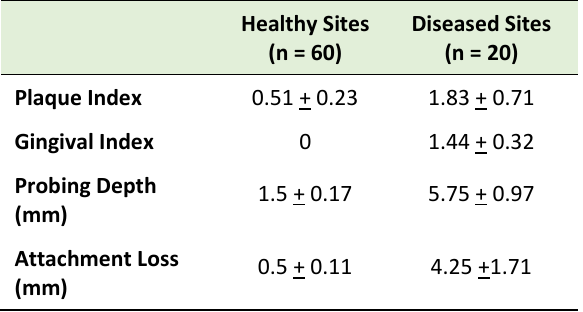
TABLE 2. Clinical measurements of healthy and diseased